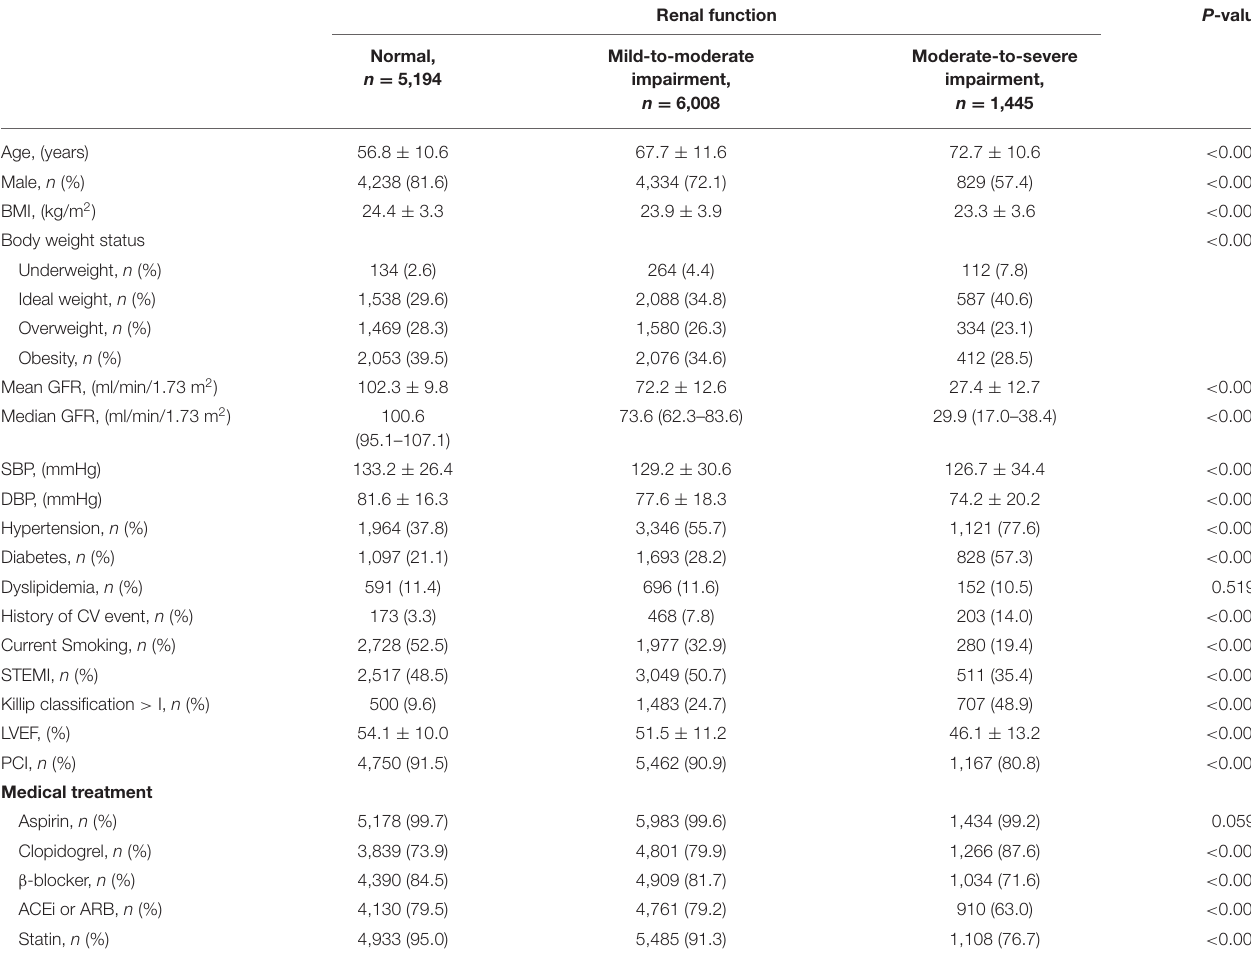
TABLE 1 | Baseline characteristics of study population.